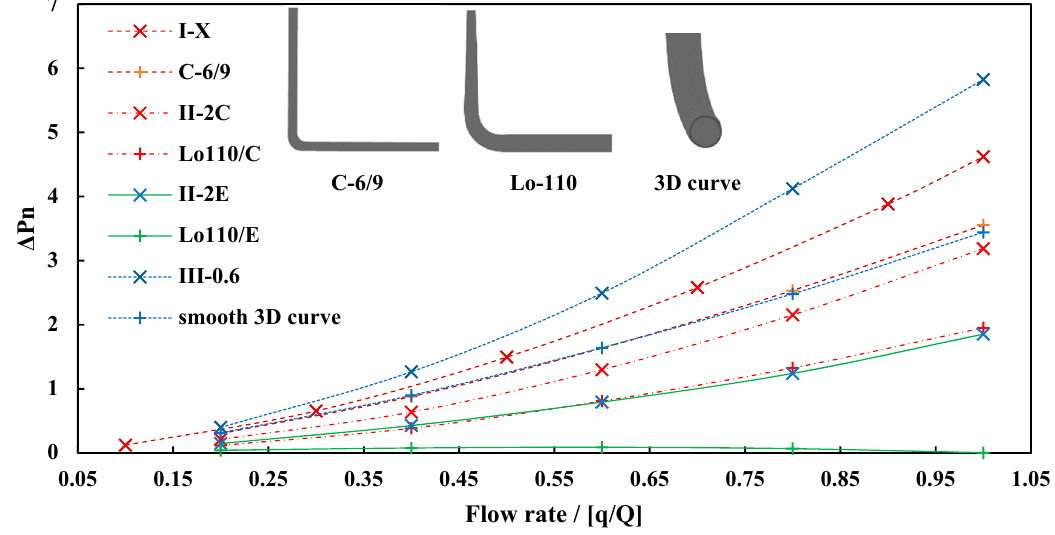
Figure 20. Comparison between traditional and optimized passages.